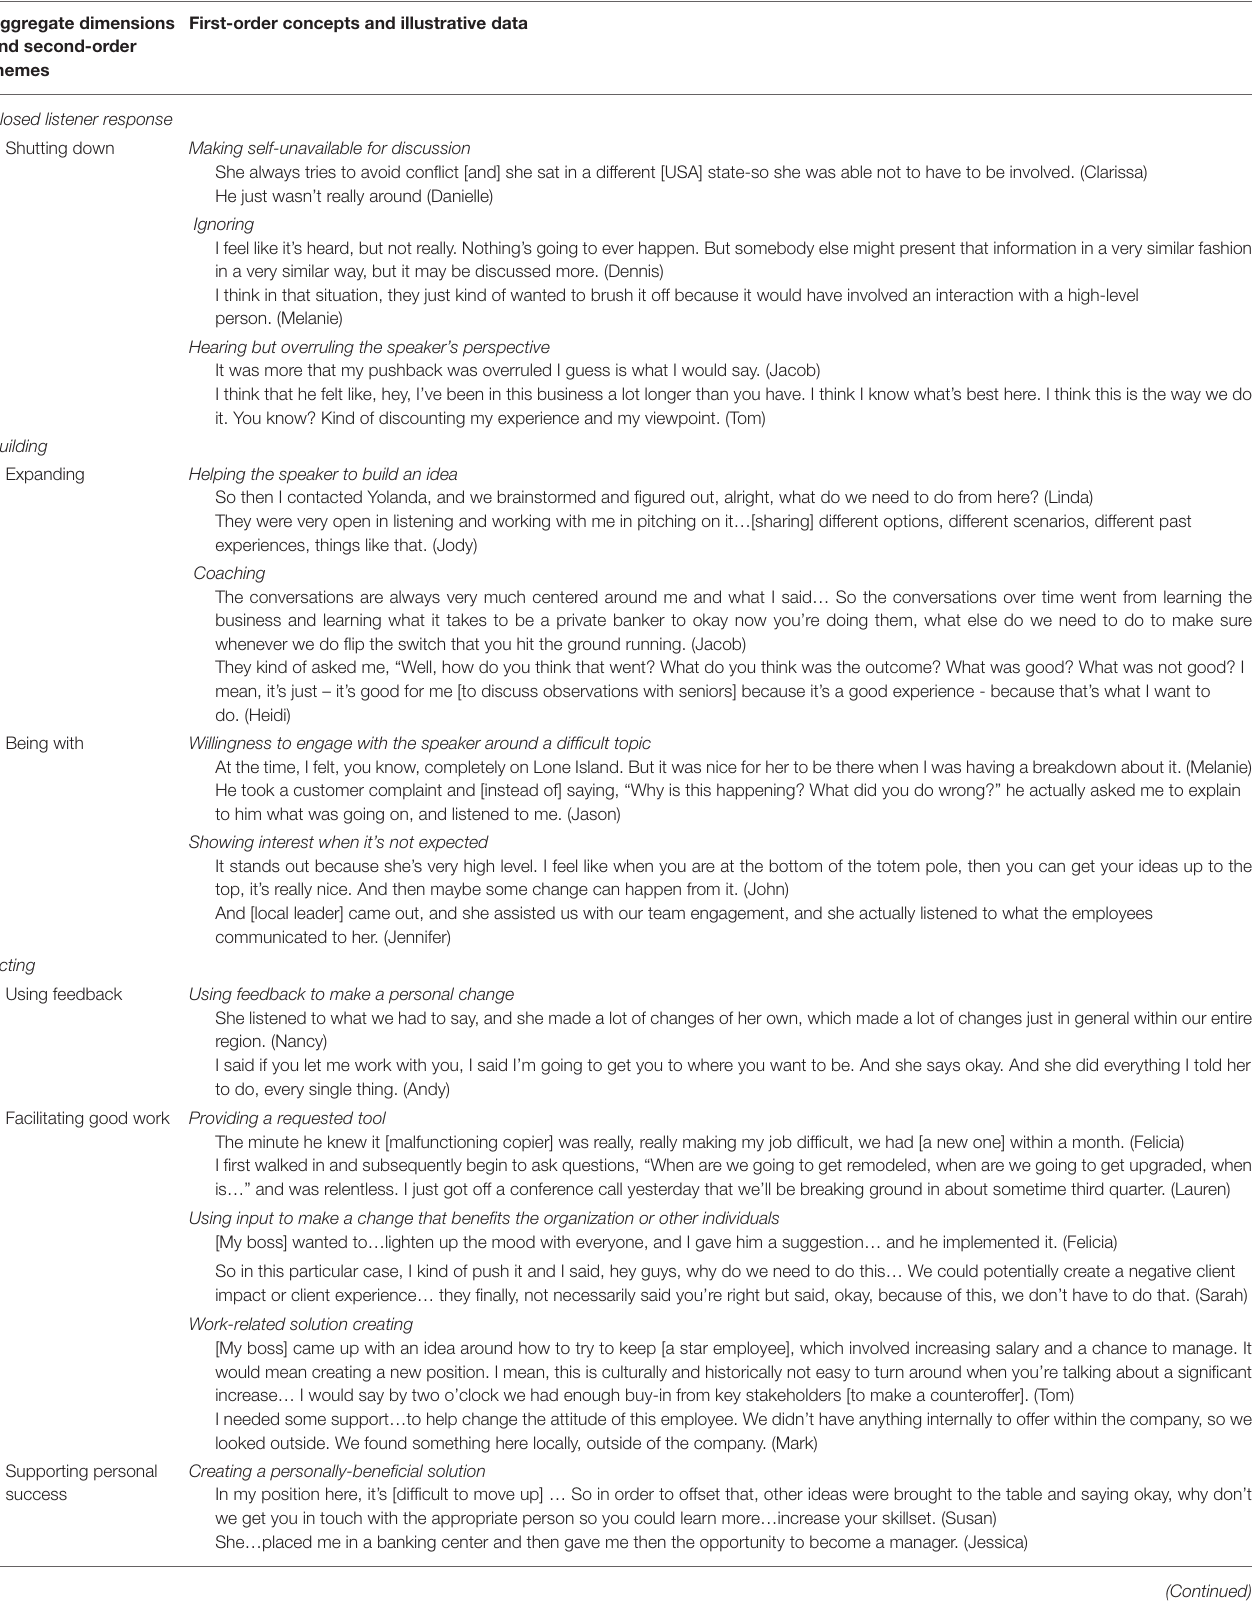
TABLE 2 | Data structure including first-order concepts, second-order themes, and aggregate dimensions. Aggregate dimensions First-order concepts and illustrative data and second-order themes Closed listener